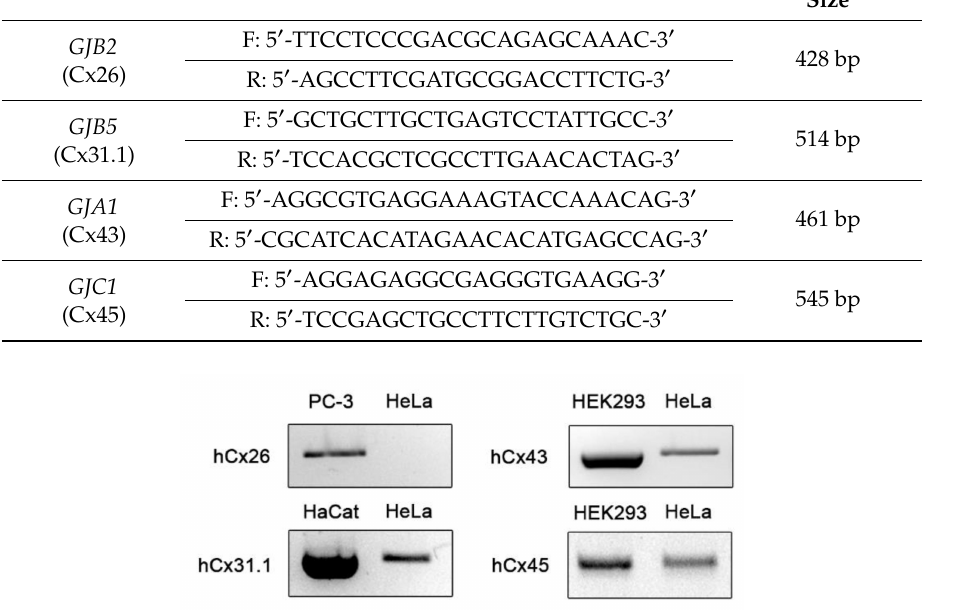
Figure 2. Cx expression at the mRNA level in HeLa cells. HeLa cell cDNA was amplified using PCR primer pairs specific for GJB2 (Cx26), GJB5 (Cx31.1), GJA1 (Cx43), and GJC1 (Cx45) shown in Table 2 and analyzed using 2% agarose gel electrophoresis. PC-3, HaCat, and HEK293 cell cDNAs were used as a positive control, as indicated